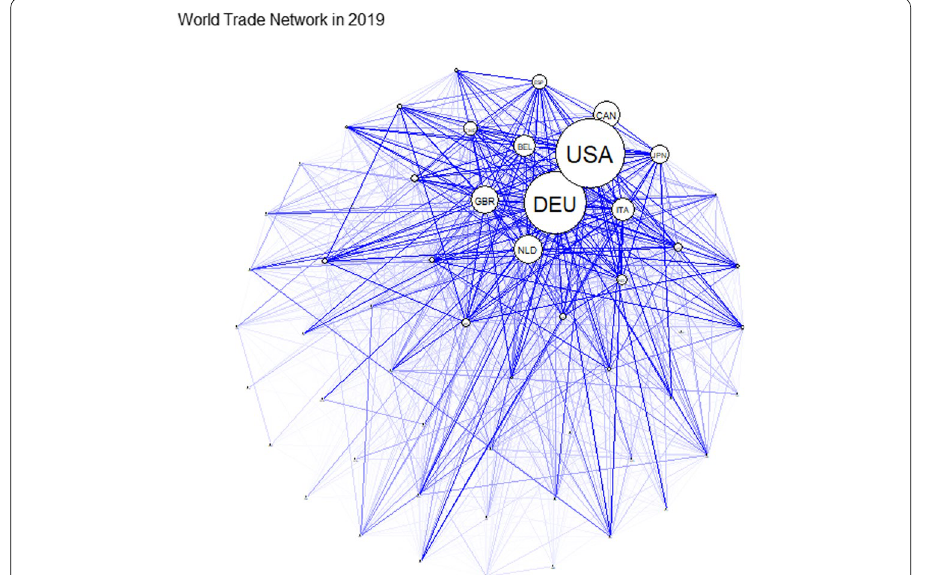
Fig. 8 WTN representation in 2019. The size of the nodes is proportional of its strength